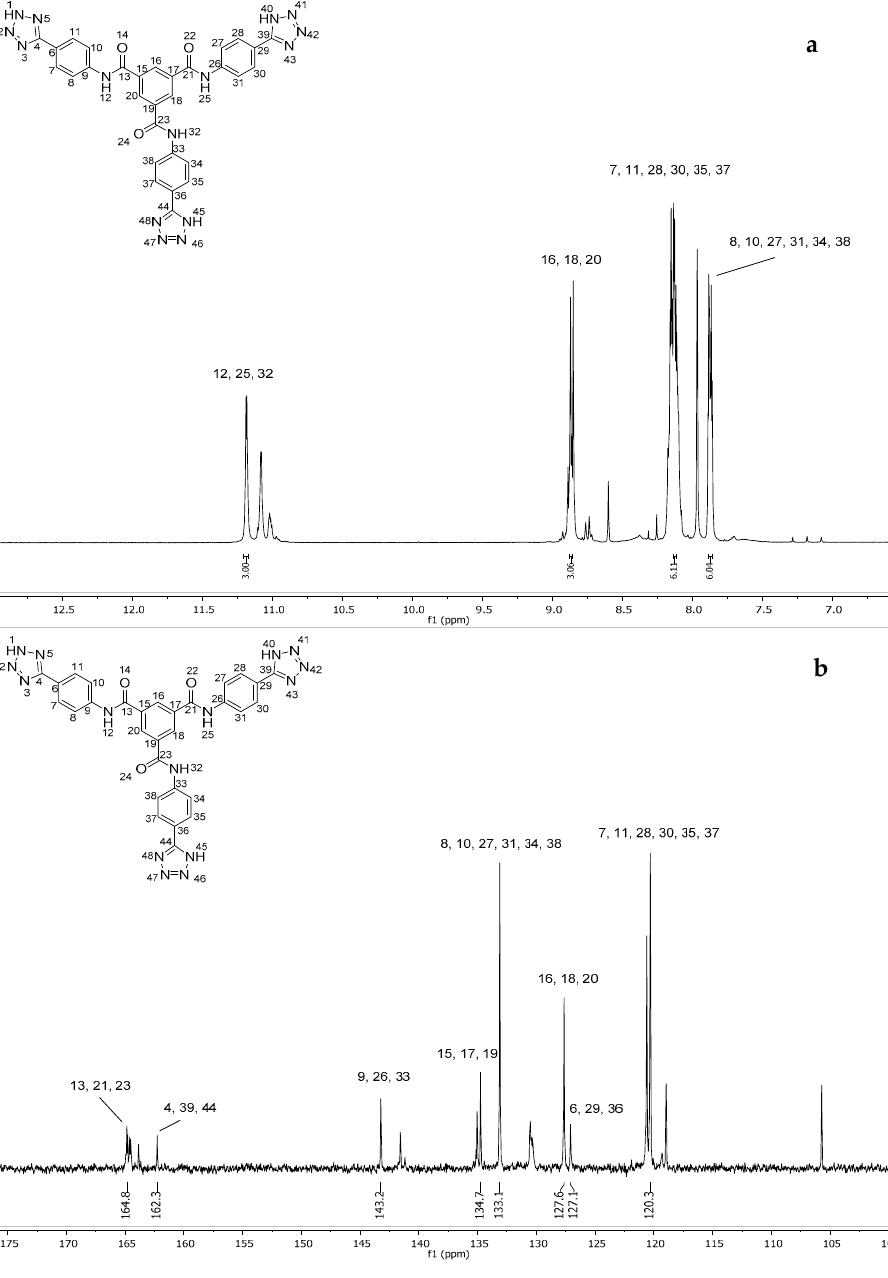
Figure 4. ( a ) 1 H NMR spectrum and ( b ) 13 C NMR spectrum of ligand 7 .